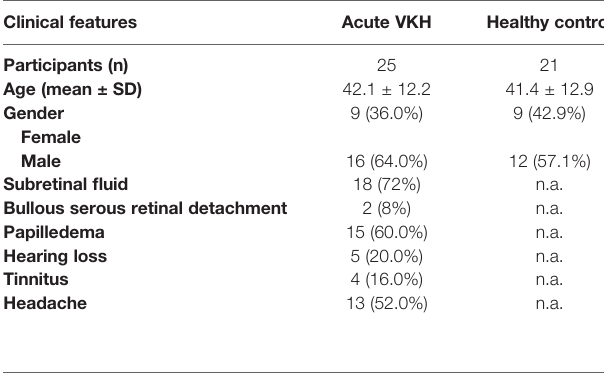
TABLE 1 | Clinical features of VKH patients and healthy controls. Clinical features